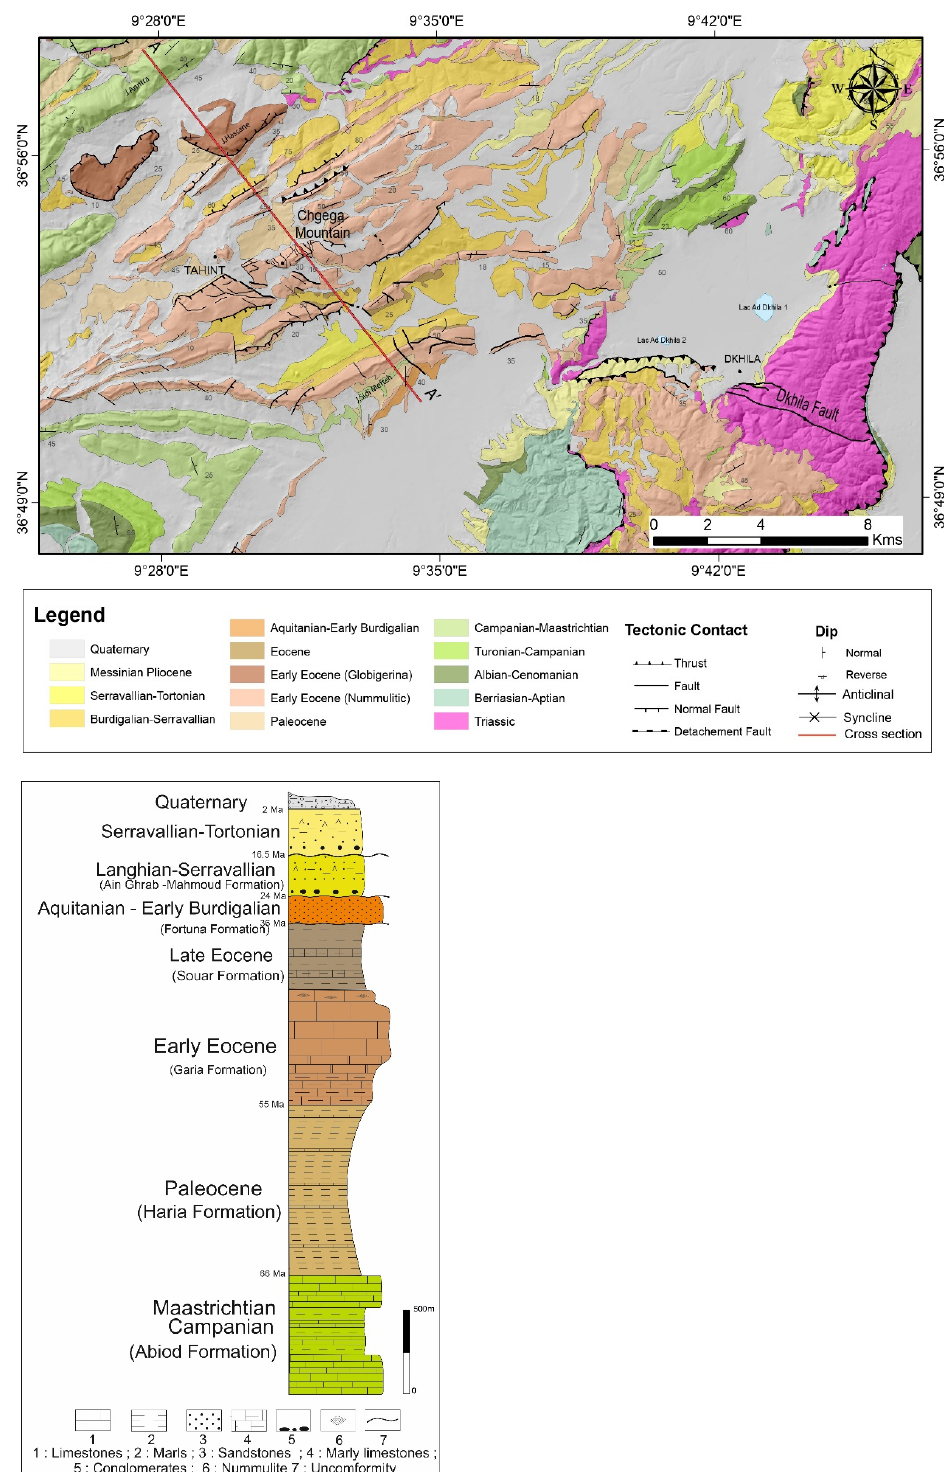
Figure 2. Geological map based on existing 1:50,000 maps published by Office Nationale des Mines [32–35] and stratigraphic column of the Chgega landslide region.